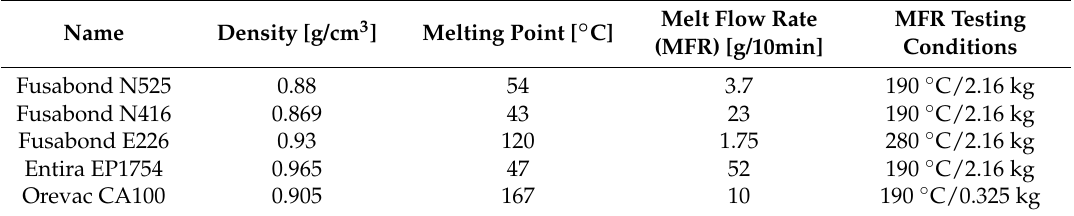
Table 7. Physical properties of the compatibilizers according to their manufacturers.